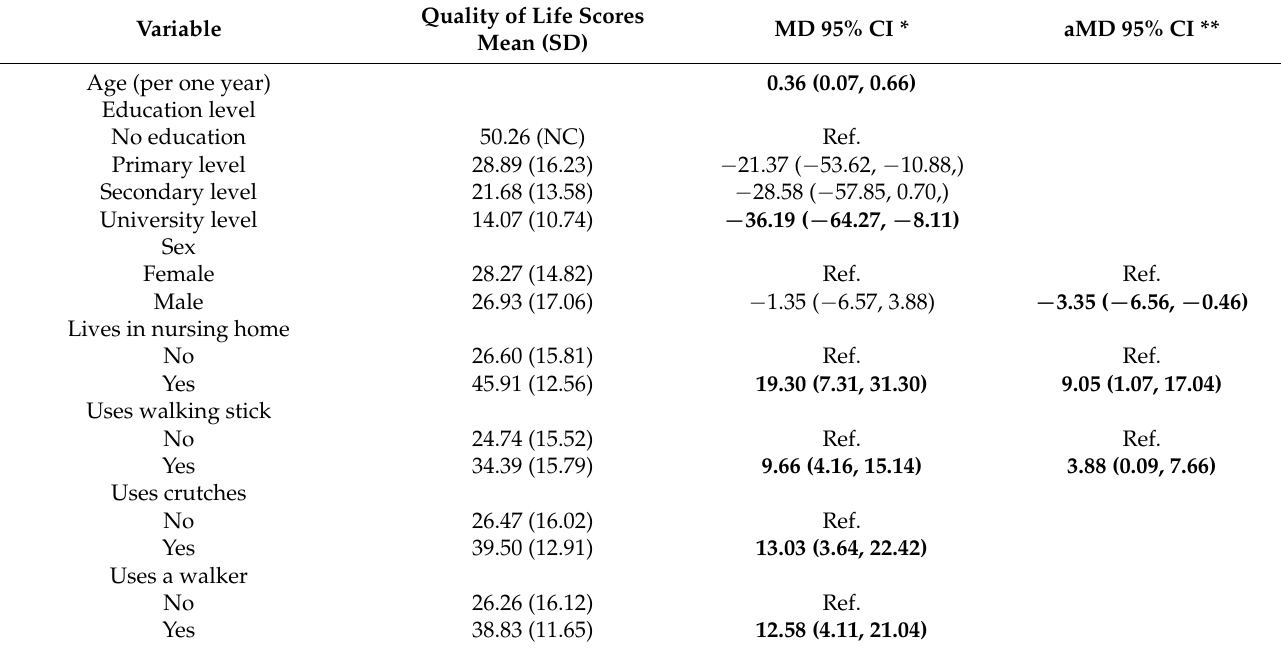
Table 2. Factors associated with quality of life in persons with Parkinson’s disease. Bivariate and multivariate analysis by linear